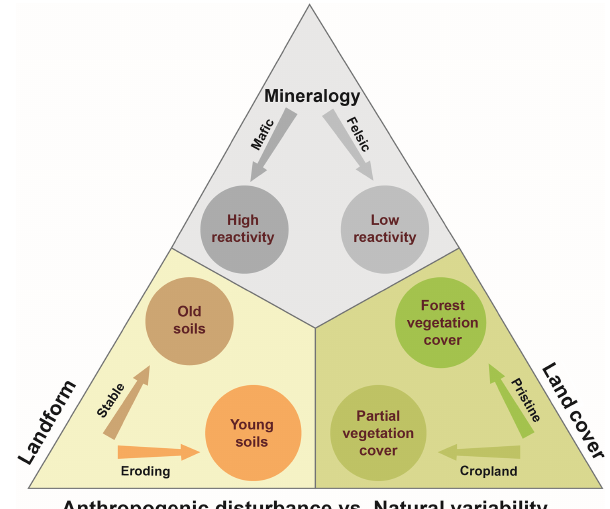
Figure 1. Factorial design of project TropSOC studying biogeo- chemical cycles in Central African tropical forest and agricultural landscapes in relation to mineralogy, landform, and land cover